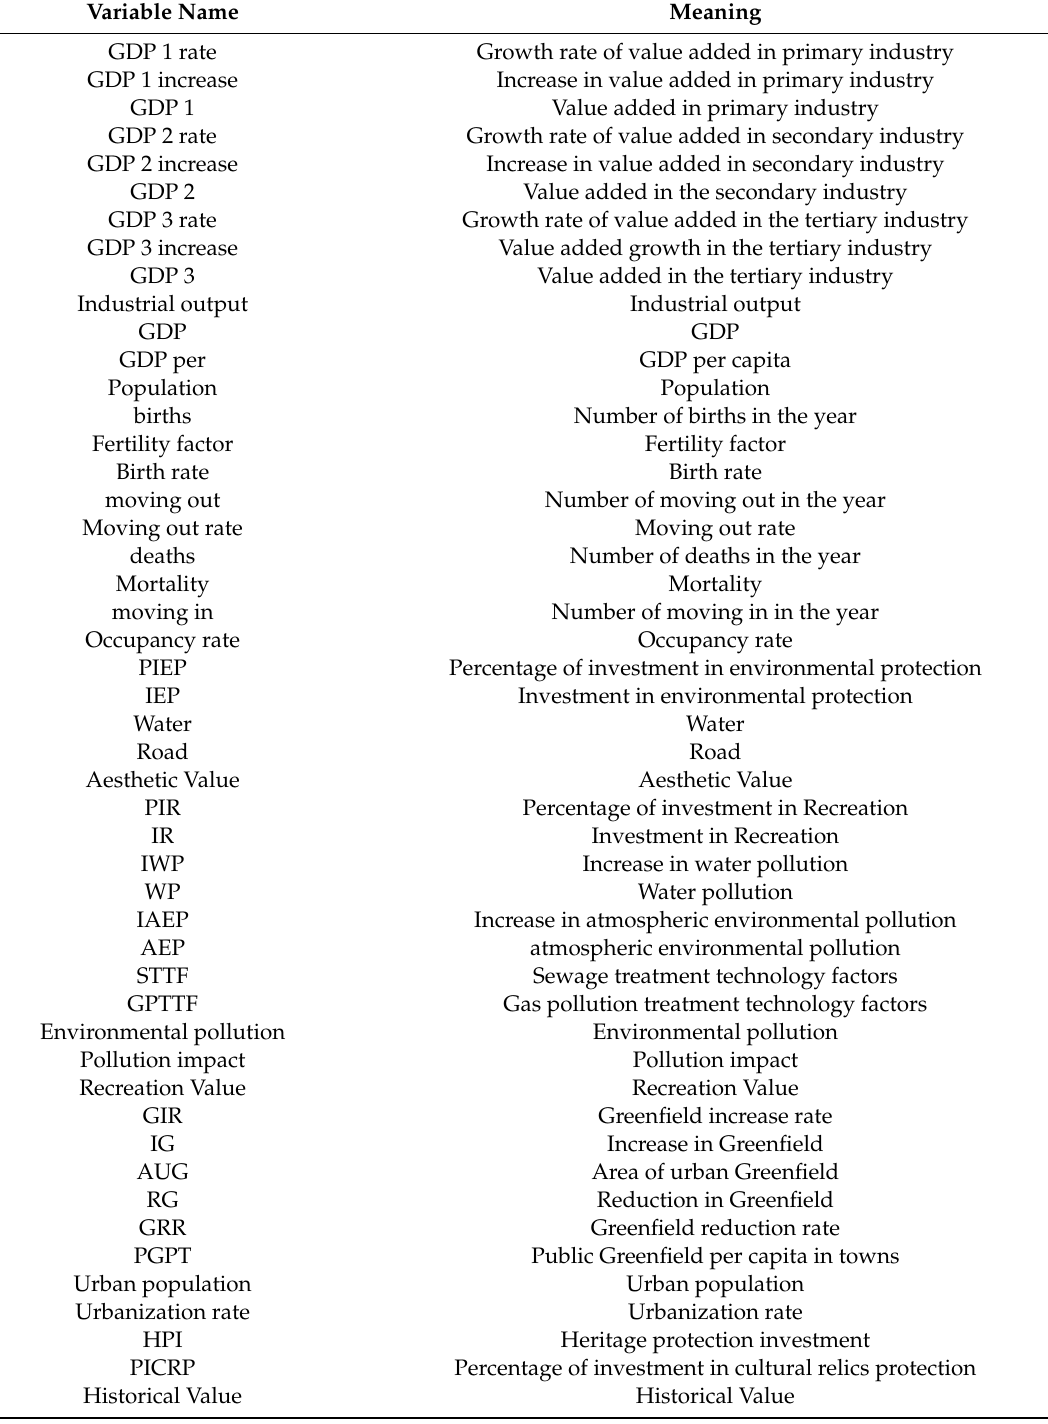
Table A1. Meaning of Variable name in